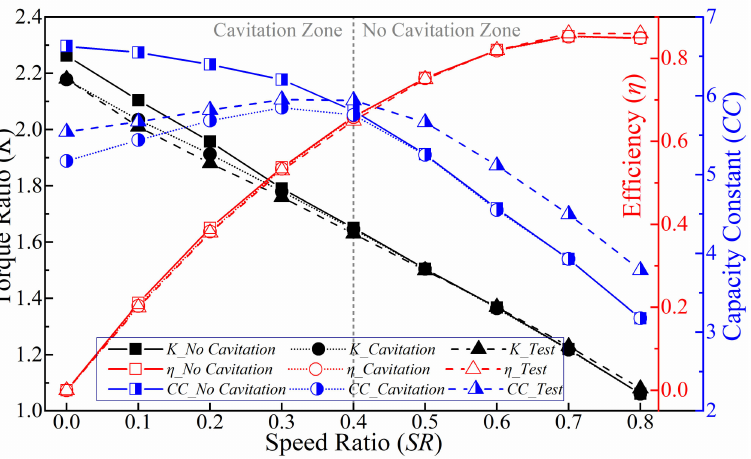
Figure 7. Comparison of torque ratio, efficiency, and capacity constant between no cavitation, cavitation, and test at various speed ratio under cavitating and non cavitating